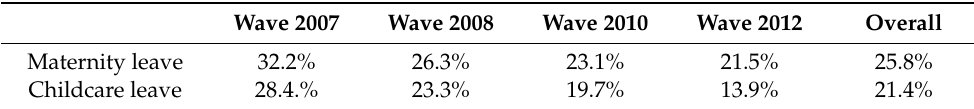
Table 2. Maternity leave and childcare leave accessibility